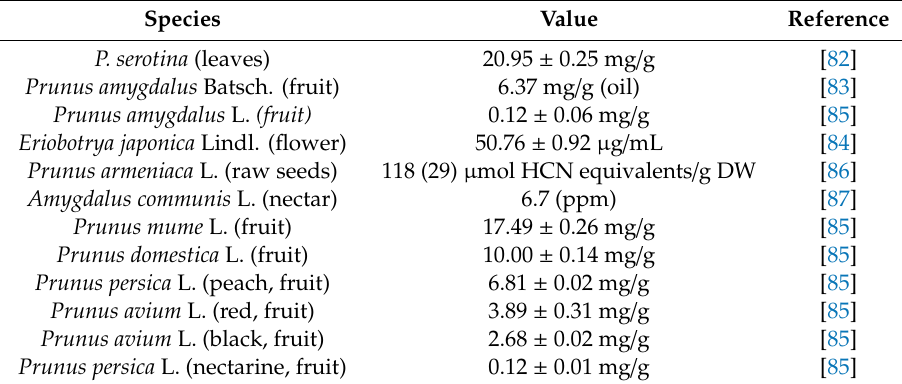
Table 6. Cyanogenic glycosides: amygdalin content in di ff erent species.